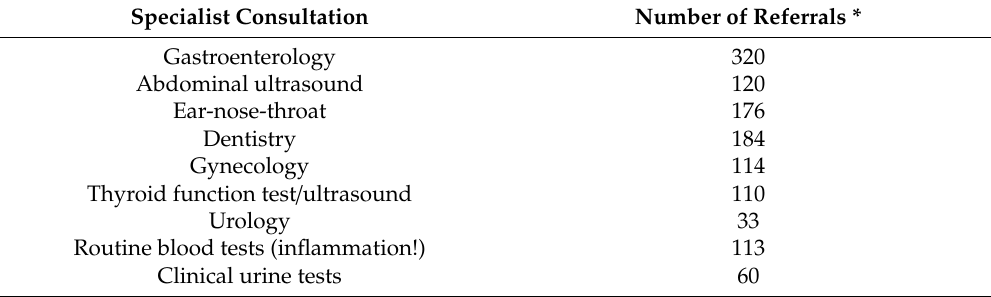
Table 5. Further referrals and examinations needed according to patients’